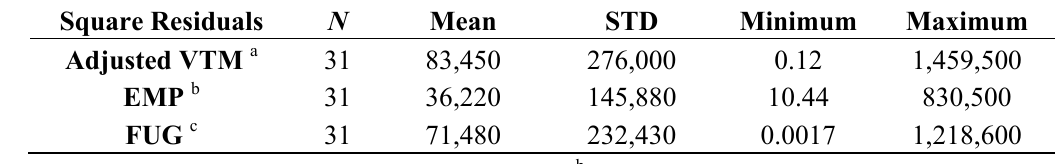
Table 8. Comparison between adjusted VTM, EMP and FUG models for their abilities to predict TCM air concentrations from TCM water concentrations on the basis of data reported in the